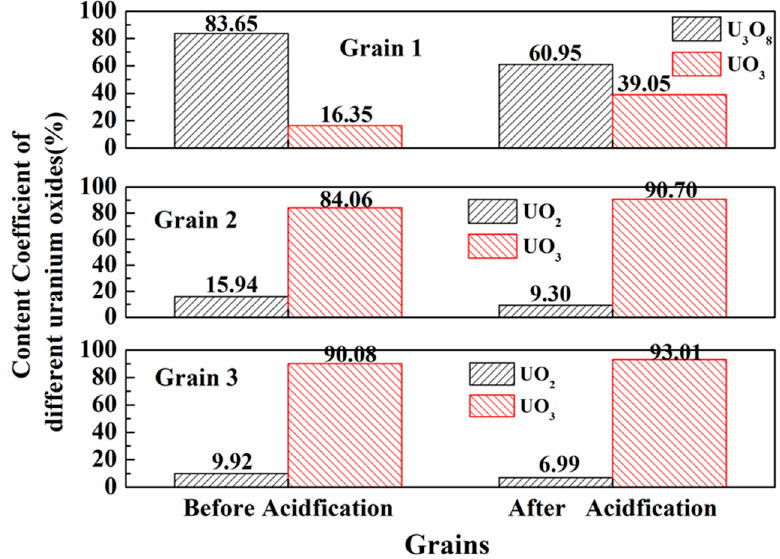
Figure 15. The variation of the uranium valence after sulfuric acid leaching.